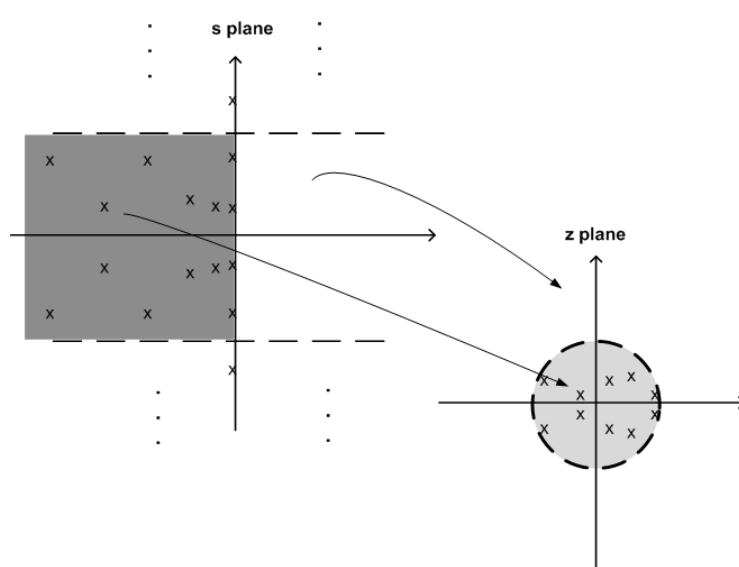
Figure 2. s to z